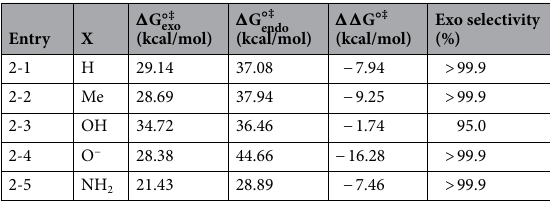
Table 6. Results of the solution-phase DFT calculations on the TSs of the five DA reactions outlined in Fig. 4.